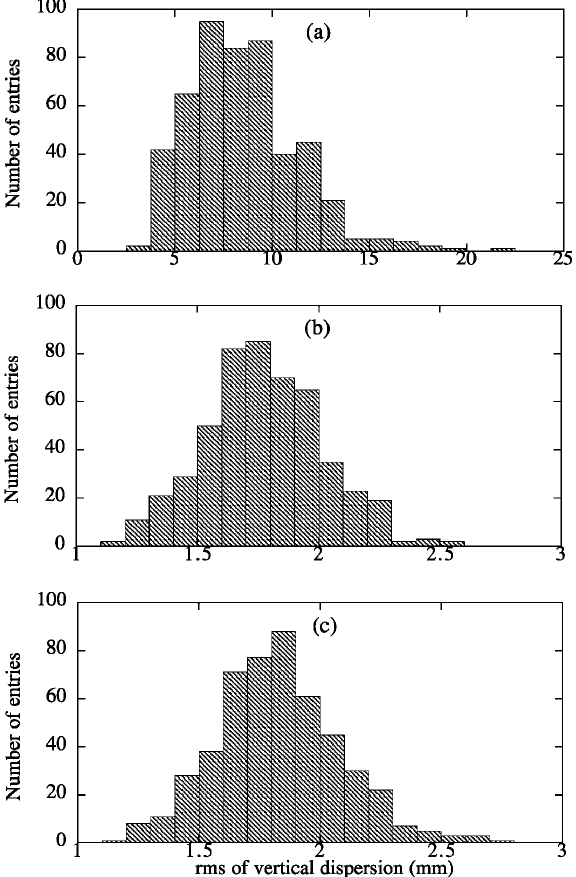
FIG. 4. Distribution of (cid:3) (mm) (a) after COD correction, arc (b) after COD-dispersion correction, and (c) after coupling correction. Note the different horizontal scales.